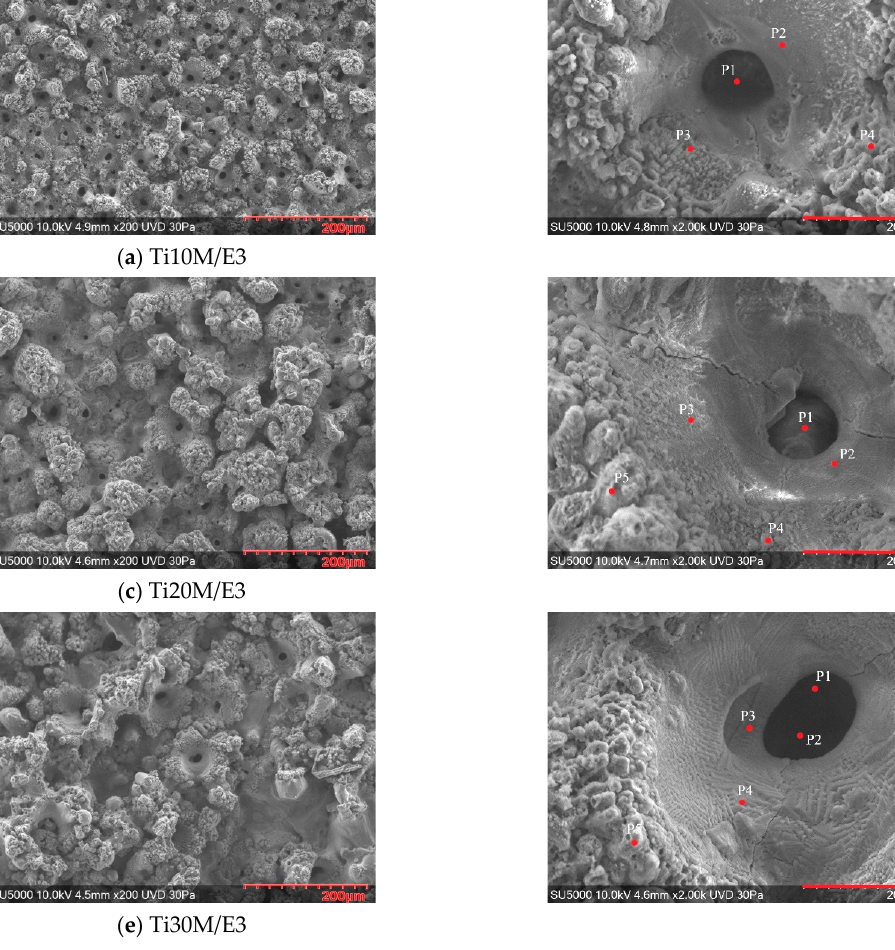
Figure 7. SEM images of the layers grown in E3 electrolyte after 10, 20 and 30 min treatment period: low magnification ( a , c , e ); high magnification and EDS analysis points ( b , d , f ); point element mass concentrations